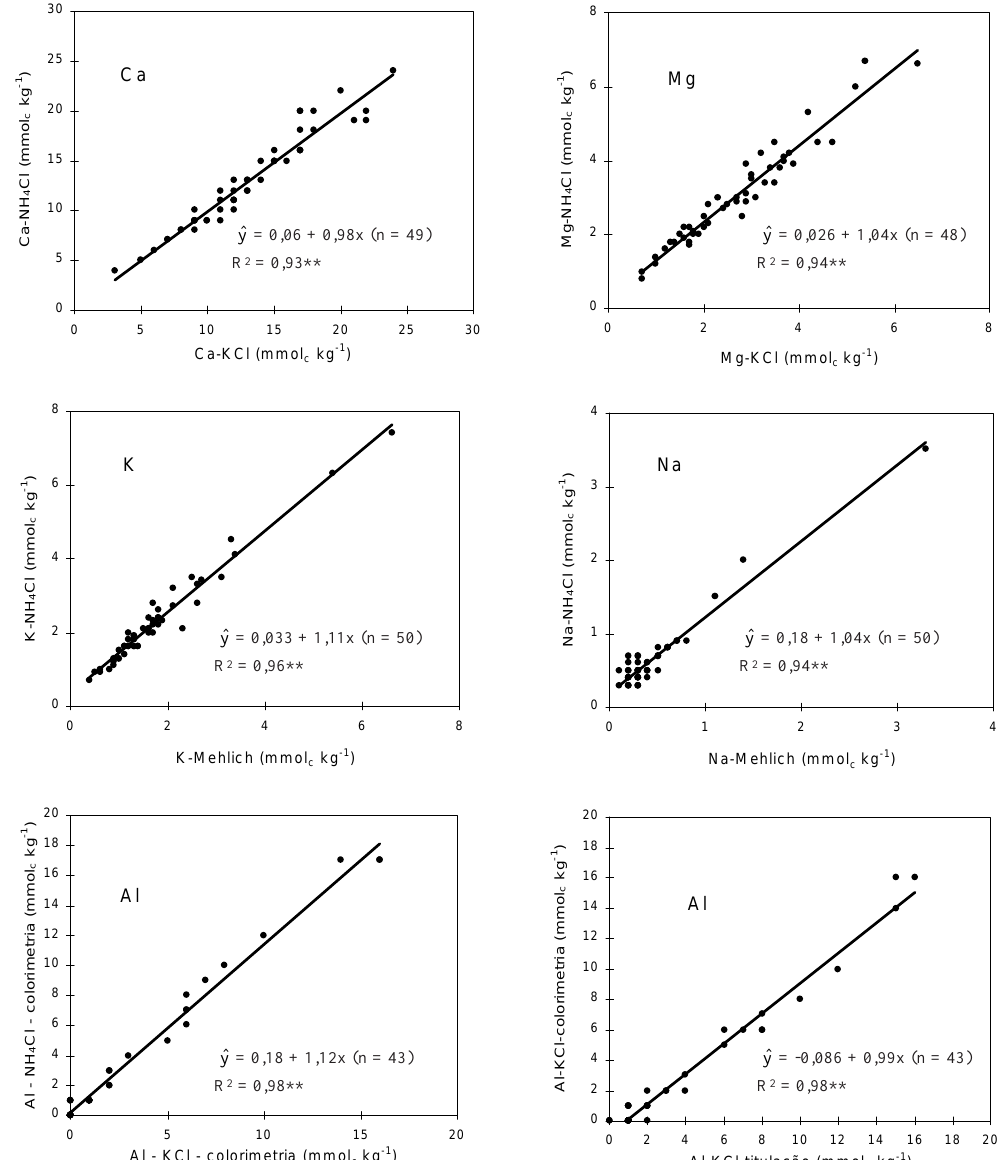
Figura 1. Relação entre teores de cátions trocáveis determinados em diferentes soluções extratoras: NH 1 mol L -1 e KCl 1 mol L -1 (Ca, Mg e Al); NH Cl 1 mol L -1 e Mehlich-1 (K e Na) e relação entre teores de 4 Al trocável extraído em solução de KCl 1 mol L -1 determinados por dois métodos: colorimetria e titulação. ** significativo (p <